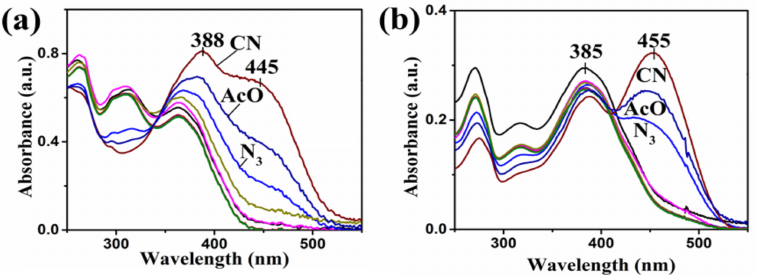
Figure 3. ( a ) UV-vis Spectra of 1 in the presence of different anions in water: acetonitrile 10:90 ( – 1 ;